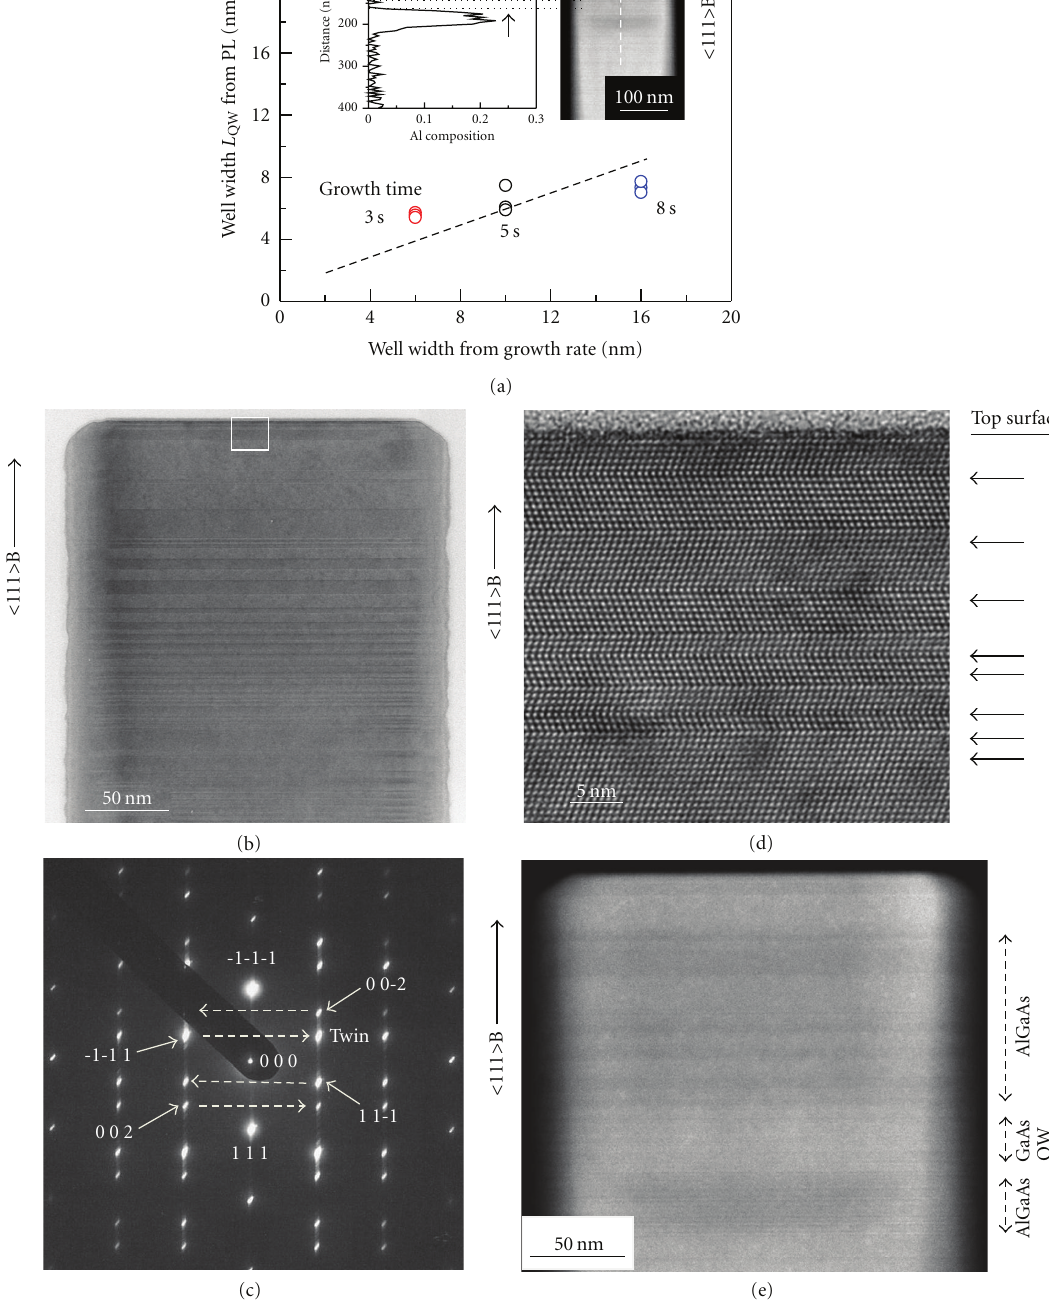
Figure 10: GaAs QW width calculated from PL spectra and growth rate and analysis by TEM. (a) Comparison of GaAs QW width obtained from PL peak energy with that estimated from axial growth rate of GaAs NW. NW pitch was 1 μ m. Inset in upper right is dark-field STEM image of heterostructure NW taken with electron-beam direction parallel to (cid:2)− 110 (cid:3) . Inset at left above has depth profile of Al composition measured from top of NW by using EDX, which indicates GaAs QW portion sandwiched by AlGaAs. White broken line along (cid:2) 111 (cid:3) direction on STEM image indicates path scanned by electron beam for EDX. (b) Bright-field STEM image of NW. (c) Transmission electron di ff raction pattern. (d) High-resolution TEM image of NW top portion indicated by white rectangle on STEM image of (b). Twin boundaries are indicated by arrows. (e) Dark-field STEM image of (b). Layer positions of GaAs QW and AlGaAs barriers estimated along (cid:2) 111 (cid:3) direction are indicated by broken arrows